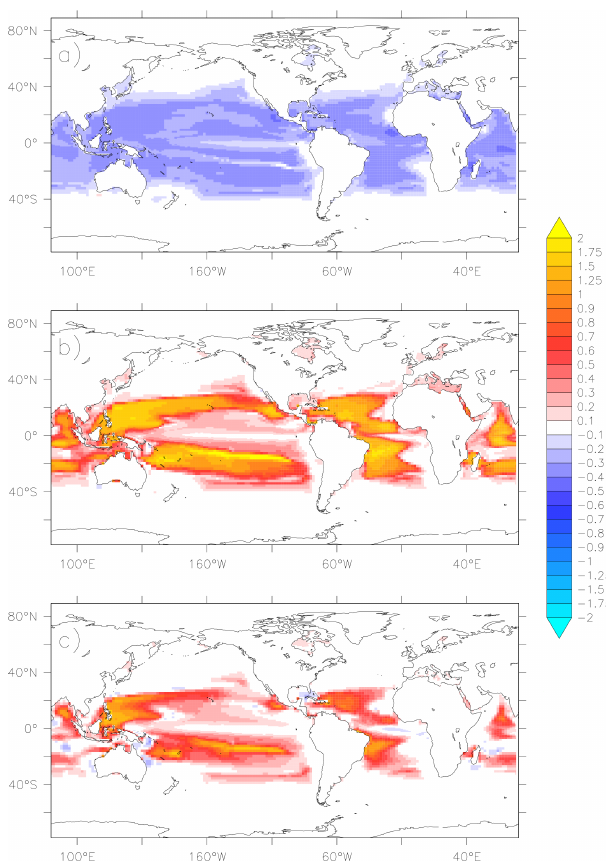
Figure 19. Annual-mean relative change in the surface carbon biomass of total phytoplankton (panel a ), microzooplankton (panel b ), and mesozooplankton (panel c ) in the FOOD experiment com- pared to the standard